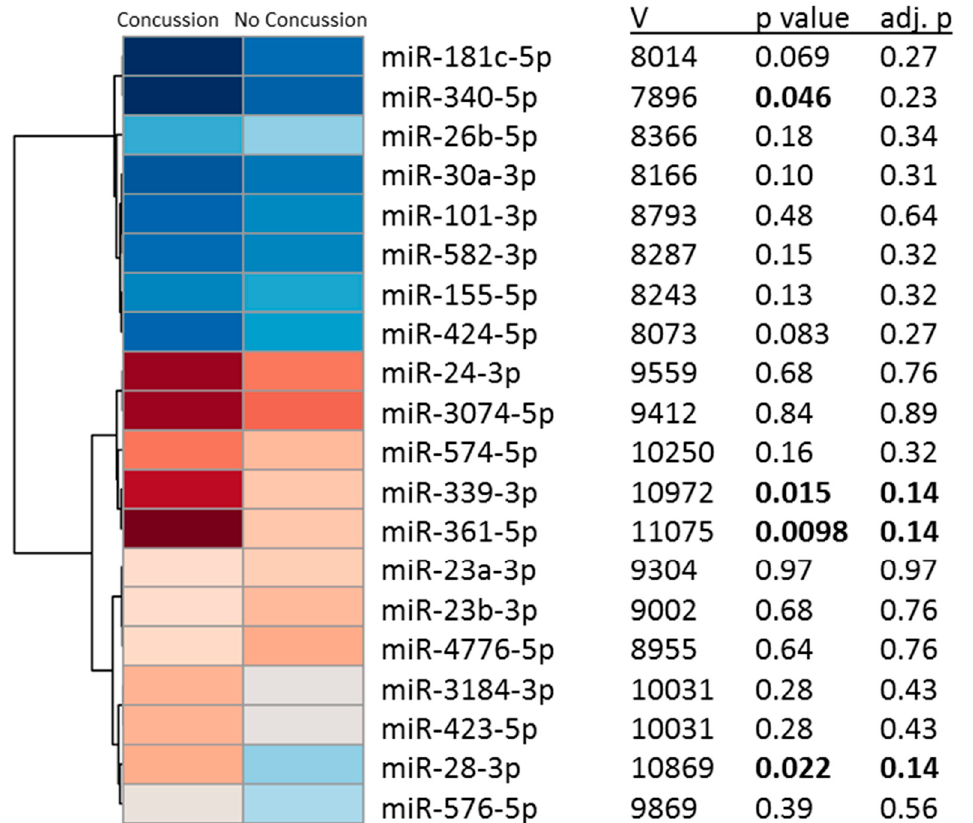
Figure 3. Three miRNA candidates di ff er among individuals with prior concussion. A non-parametric analysis of variance comparing levels of the 20 miRNA candidates identified in former professional football athletes, identified three miRNAs (miR-339-3p, miR-361-5p, and miR-28-3p) nominal di ff erences ( p < 0.05; adjusted p < 0.15) between individuals with prior concussion, and those without prior concussion. Red denotes increased expression, while blue denotes decreased expression. Notably, for 2 / 3 miRNAs (miR-339-3p and miR-361-5p), expression levels among individuals with prior concussion mirrored di ff erences observed in former professional football